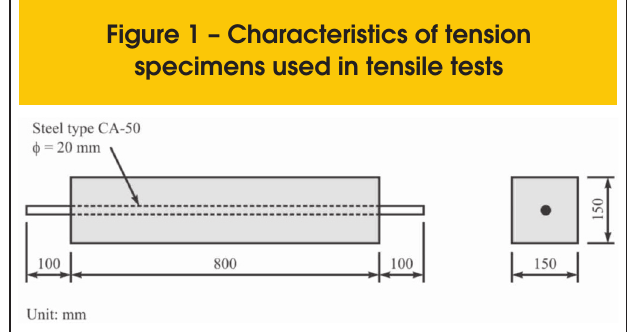
Figure 1 – Characteristics of tension specimens used in tensile